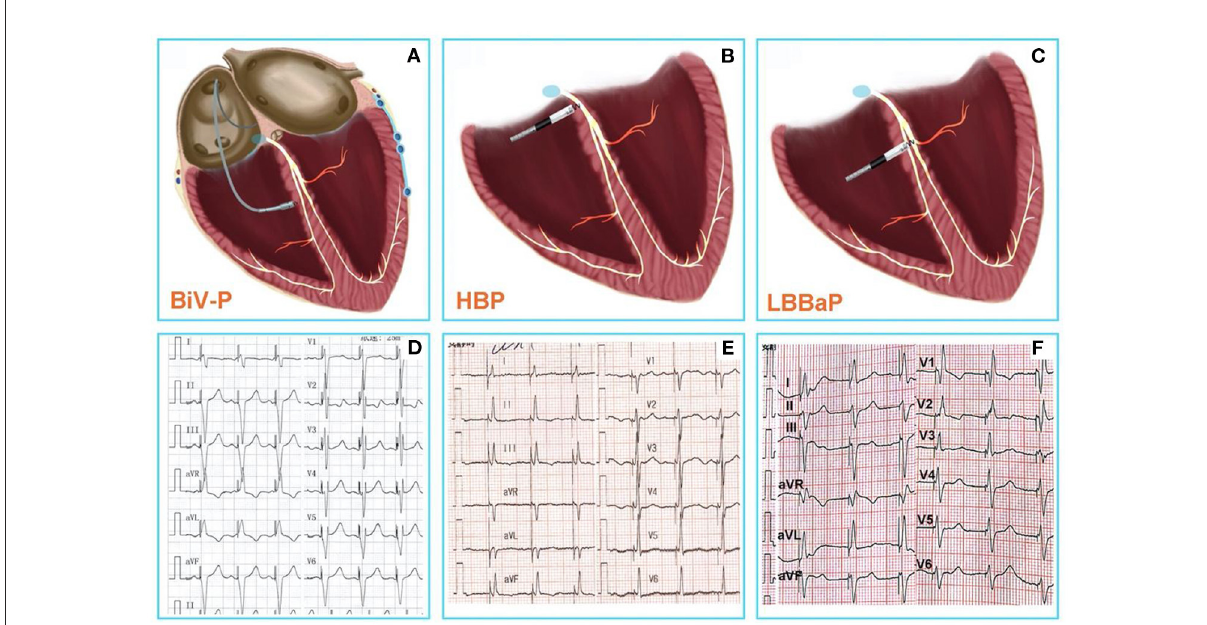
FIGURE1 (A) Conventional CRT using BiV-p based on right ventricular pacing and coronary venous pacing. (B) HBP-the real physiological pacing modality directly activate the specialized conduction system. (C) LBBaP is pacing at more distal and deeper area than HBP, and pacing the left bundle branch region directly. (D) The 12-lead ECG after BiV-p, the paced QRS duration was 134 ± 15ms (7). (E) The 12-lead ECG after HBP, the paced QRS duration was 103.8 ± 13ms (8). (F) The 12-lead ECG after LBBaP, the paced QRS duration was 114.1 ± 10.7ms (8). CRT, Cardiac resynchronization therapy; BiV-p, biventricular-pacing; HBP, His bundle pacing; LBBaP, left bundle branch area pacing; ECG,